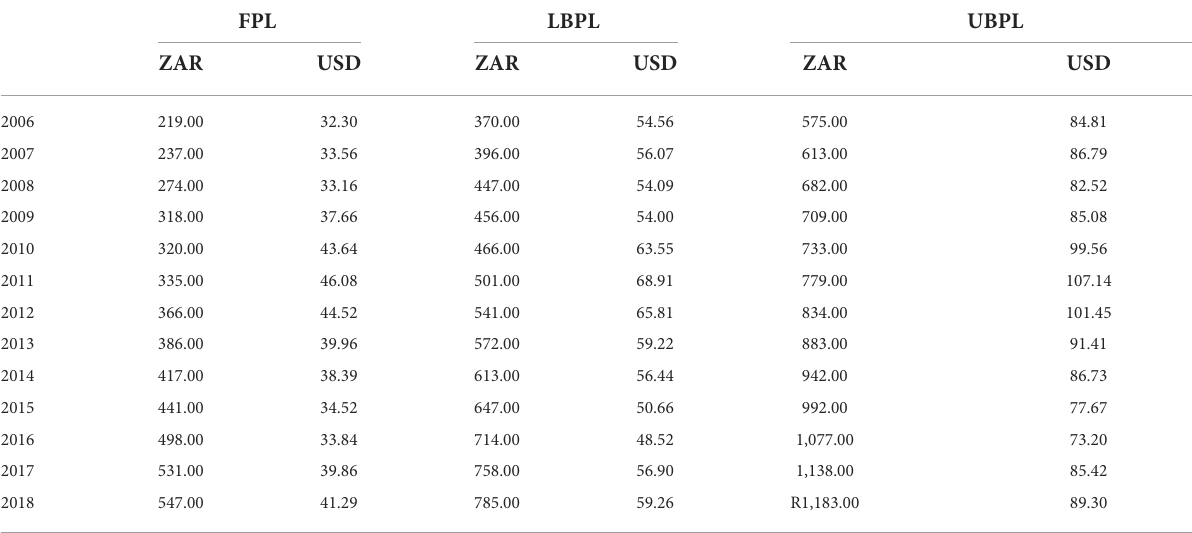
TABLE 1 The national poverty lines for South Africa from 2006 to